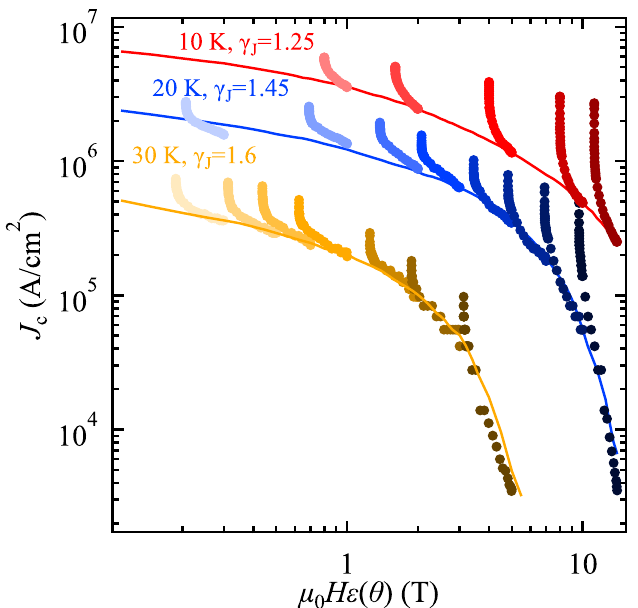
Figure 6. Scaling behaviour of J c ( θ ) as a function of effective field. All J c ( θ ) data except for those where the contribution of the ab -correlated pinning is dominant fall onto the measured curves of J c ( i . e ., field dependence of J c for H || c (lines), shown in Fig. 4a) with γ J values of